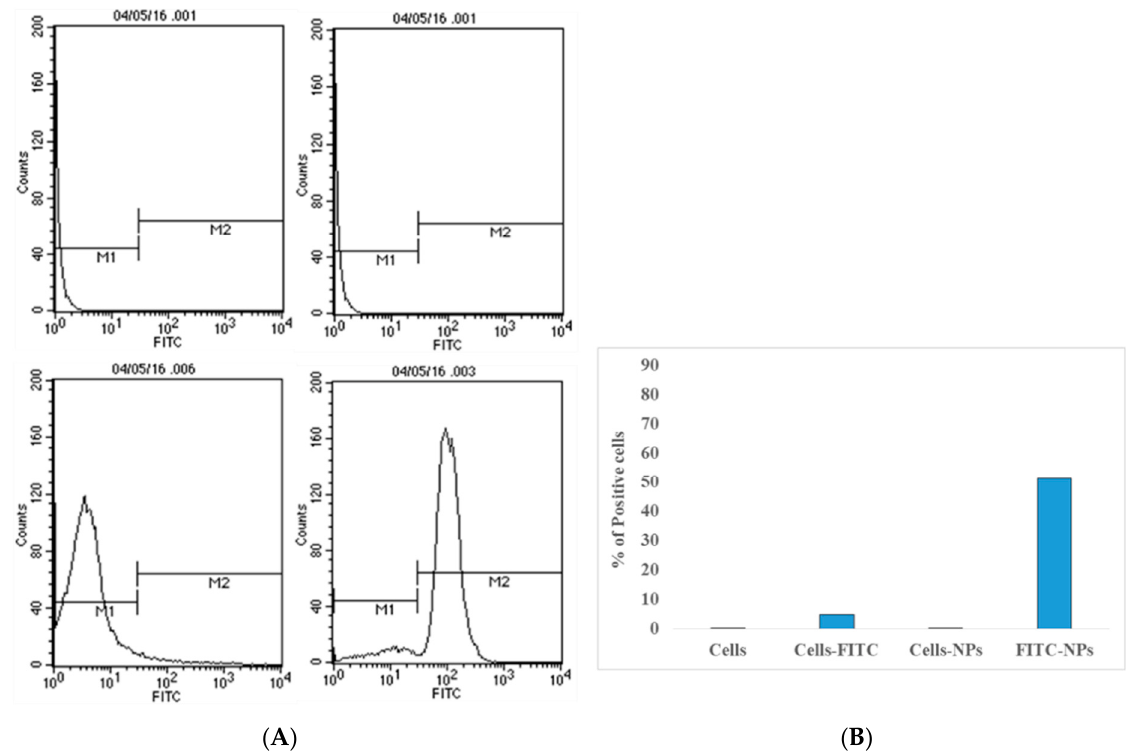
Figure 3. Cellular uptake of FITC dye-loaded chitosan nanoparticles ( A ) histogram of cells and ( B ) percentage of cell uptake of dye-loaded nanoparticles using flow cytometry analysis ( n = 3, ±SD).